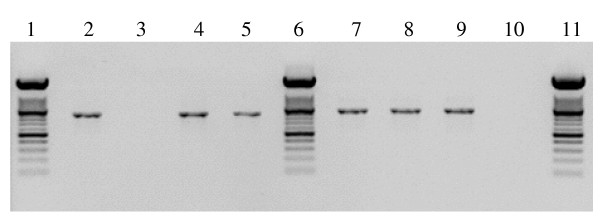
Agarose gel analyses of selected target and non-target strains after amplification of the DNA using the PCR system established by Keyser et al. [10] and the system developed in this study. Lane 1, 6, 10: MWM (Roche XIV), lane 2: E. sakazakii ATCC 29004, 3: E. sakazakii ATCC 51329, 4: E. sakazakii fruit powder isolate, 5: E. cloacae, wild strain amplified with the Keyser PCR system; lane 7 – 10 same strains amplified with the system developed in this study.